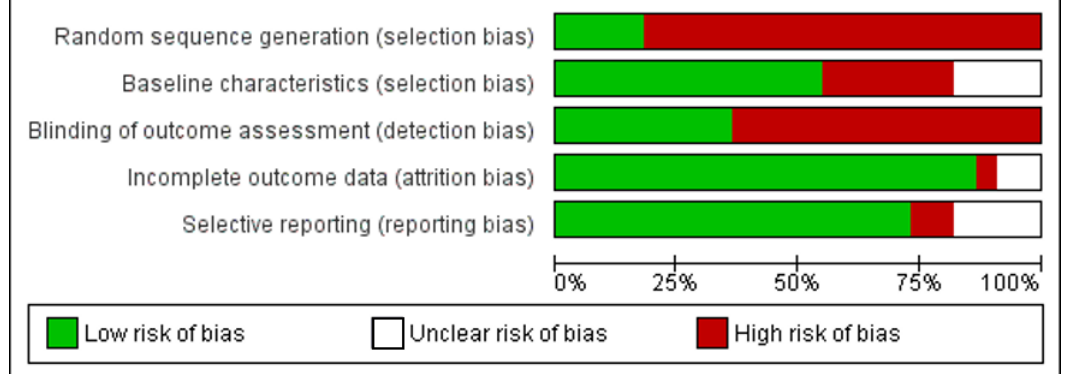
Figure 3. Risk-of- bias graph: review authors’ judgement about each risk of bias item presented as percentage across all included animal studies.